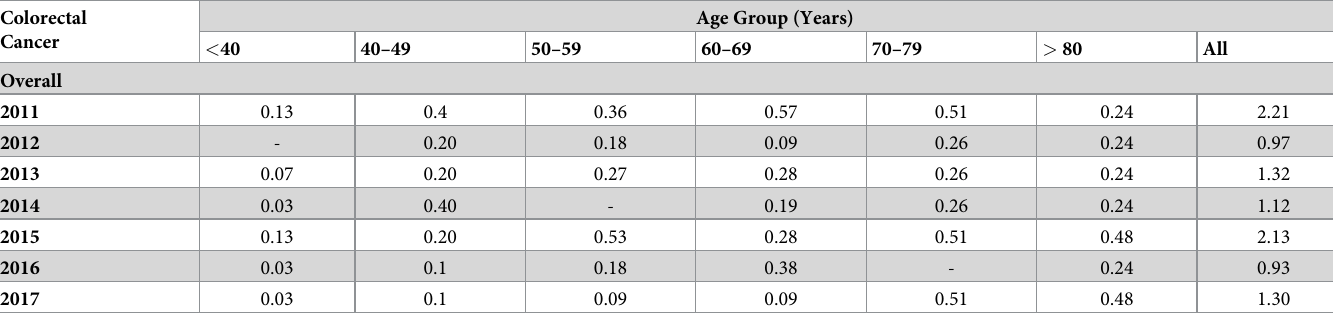
Age Group (Years)